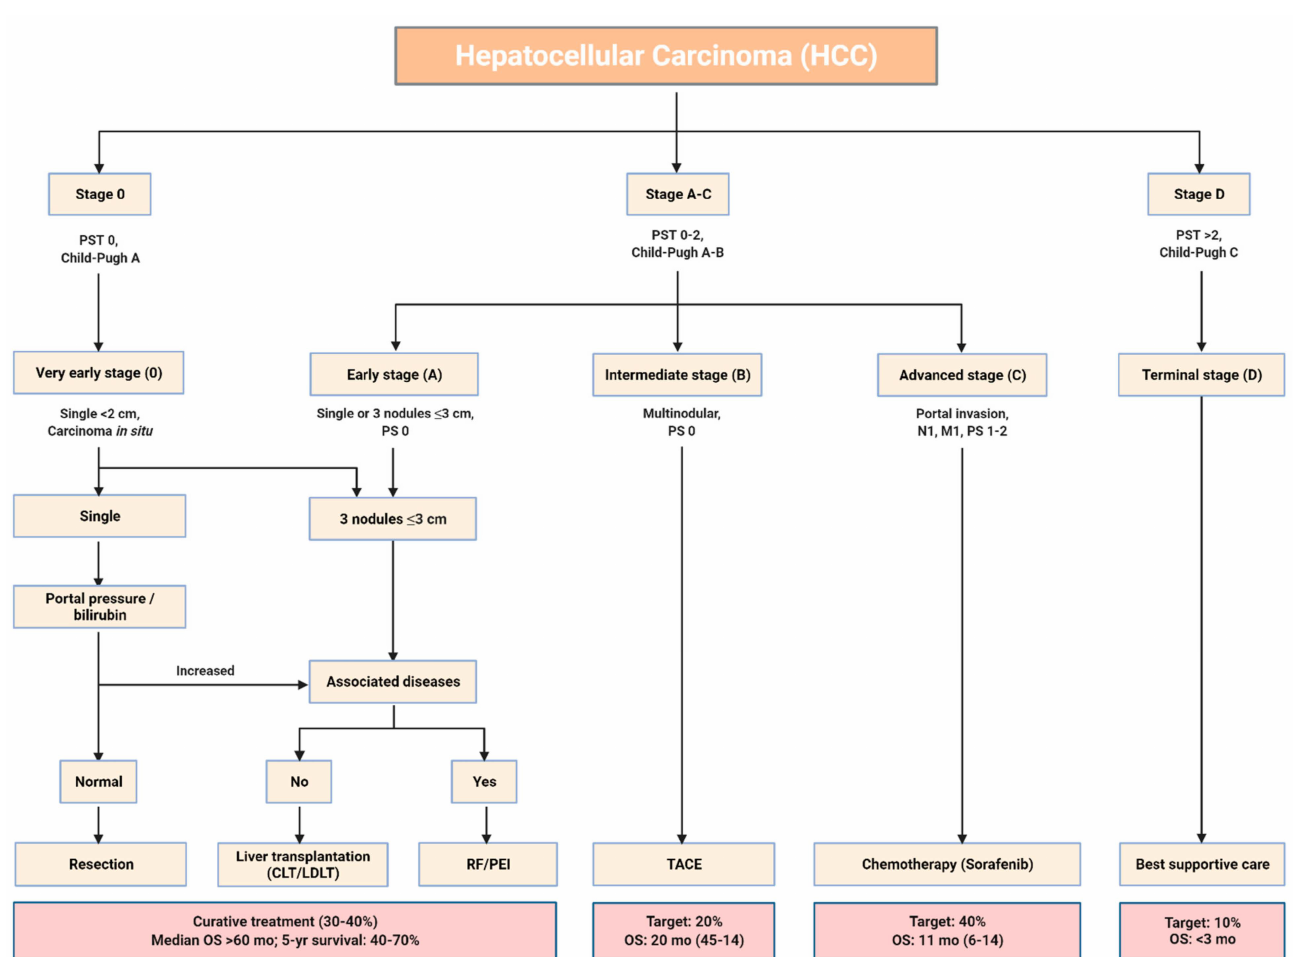
Figure 1. Barcelona Clinic Liver Cancer (BCLC) staging classification. Abbreviation: PST: performance status test; PS: performance status; CLT: cadaveric liver transplantation; LDLT: living donor liver transplantation; RF: radio-frequency ablation; PEI: percutaneous ethanol injection; TACE: trans- arterial chemoembolization; OS: overall